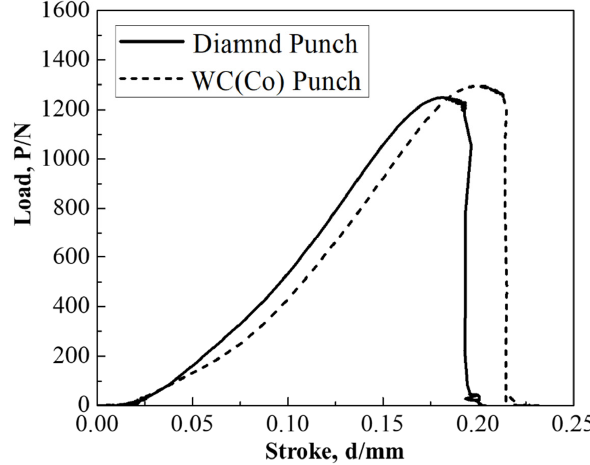
Figure 11. Comparison of the load–stroke relationships between the piercing processes by two punches.